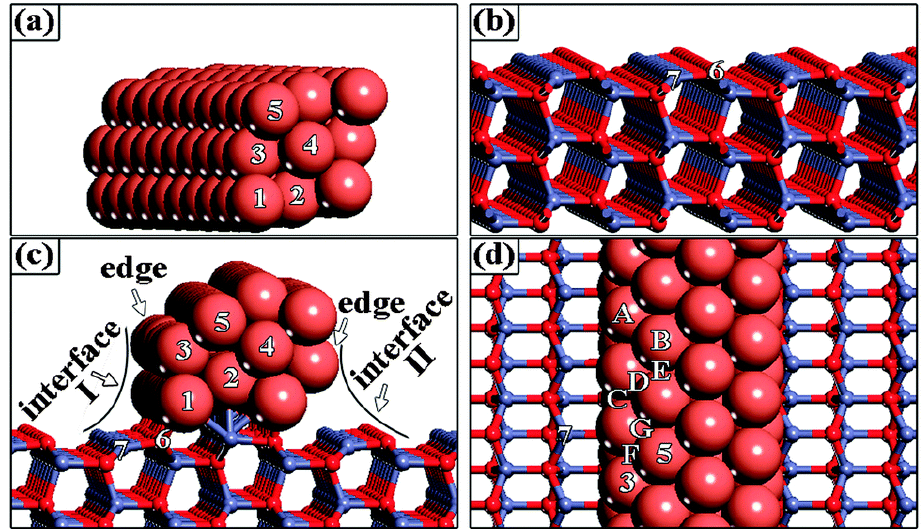
Figure 5. Catalyst model for the DFT + U calculations; an isolated ( a ) Cu(111) strip, ( b ) ZnO(10 1 ̅ 0), ( c ) side and ( d ) top views of the Cu / ZnO catalyst model. Reprinted with permission from [56]. Copyright (2015) Royal Society of Chemistry.